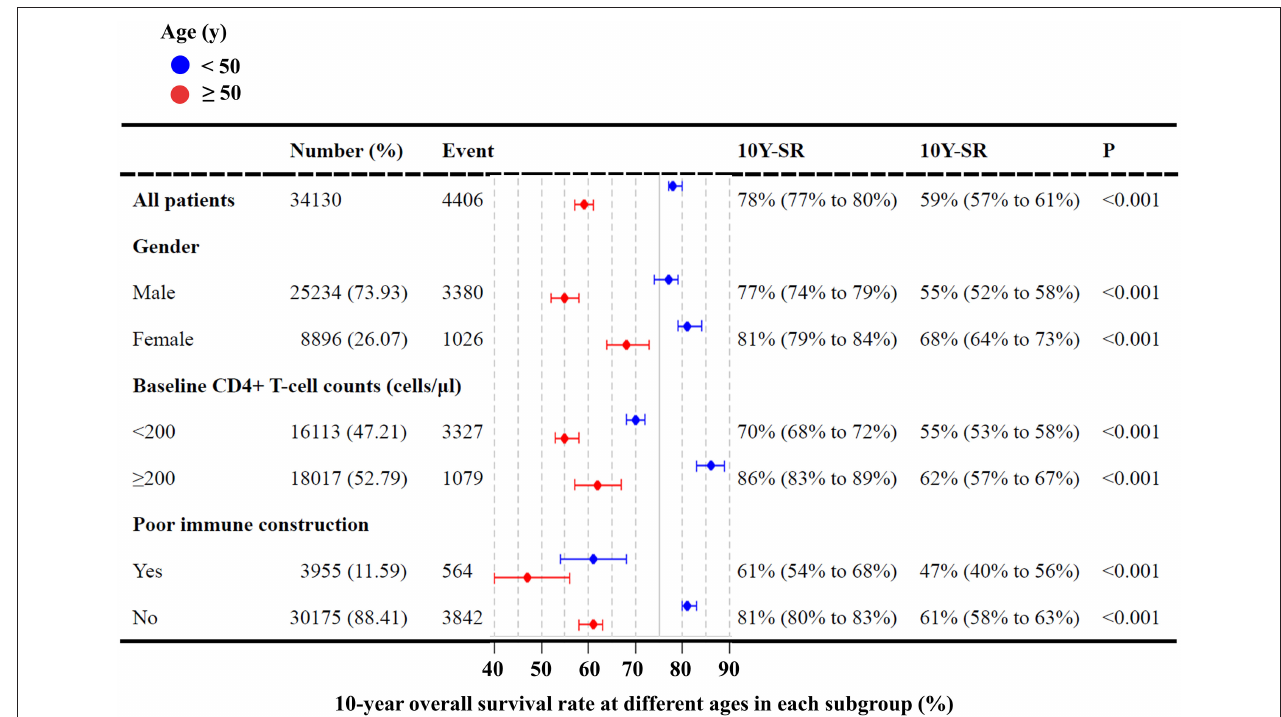
FIGURE 7 | Survival rates of HIV-infected patients in different groups. 10Y-SR indicates the 10-year survival rate.